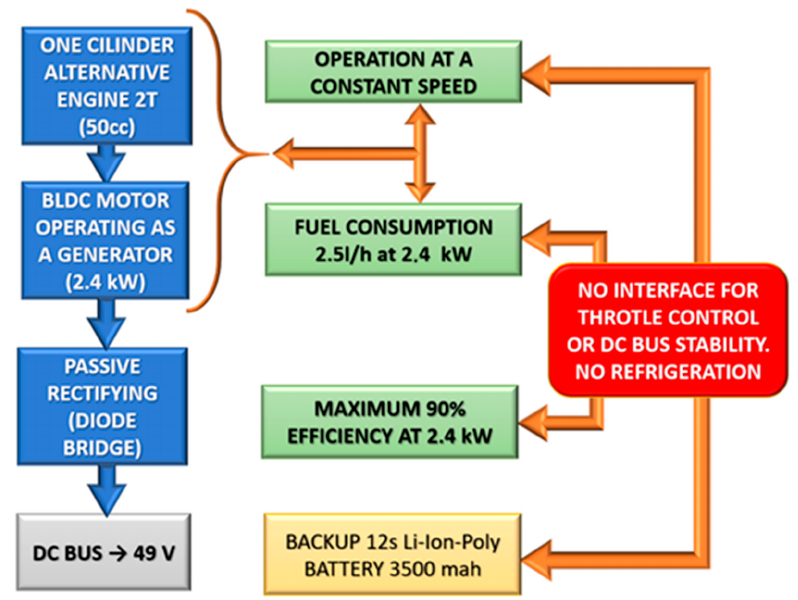
Figure 4. Block diagram of the NOVA2400-Foxtech™ generator.